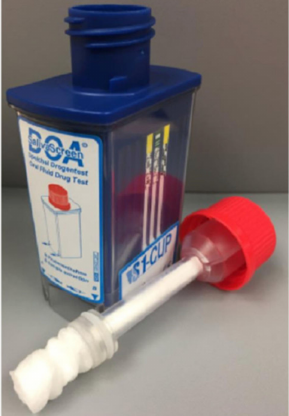
Figure 14. SalivaScreen device (reproduced with permission from Elsevier